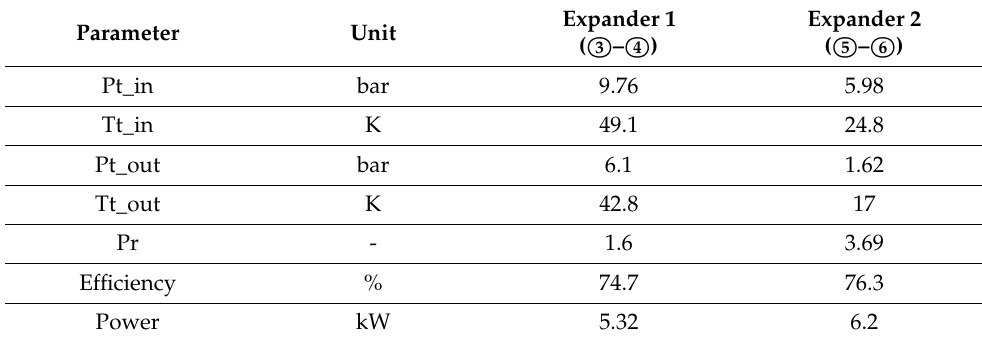
Table 2. Operation conditions of Expanders 1 and 2.